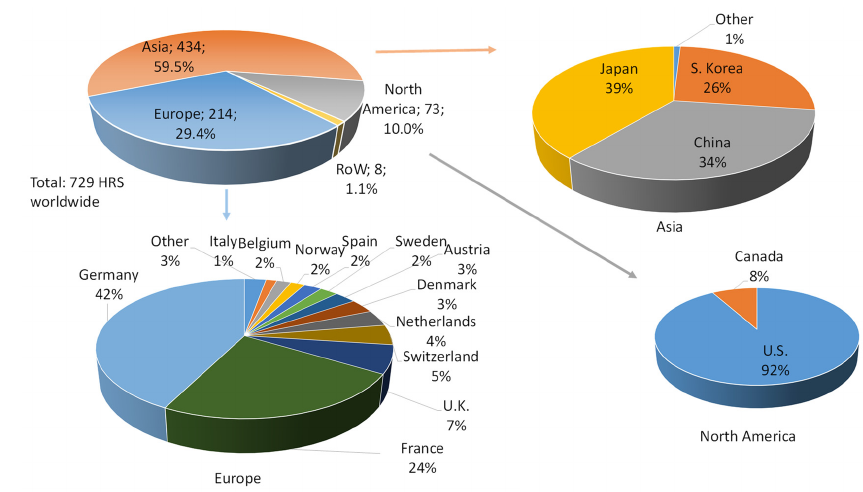
Figure 8. Distribution of hydrogen refueling stations by continent.